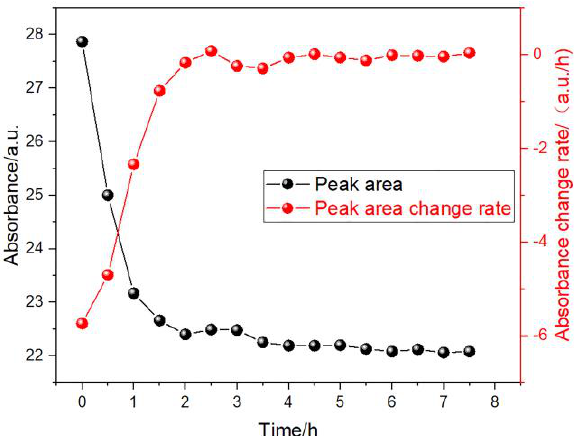
Figure 7. Group change at ambient temperature.